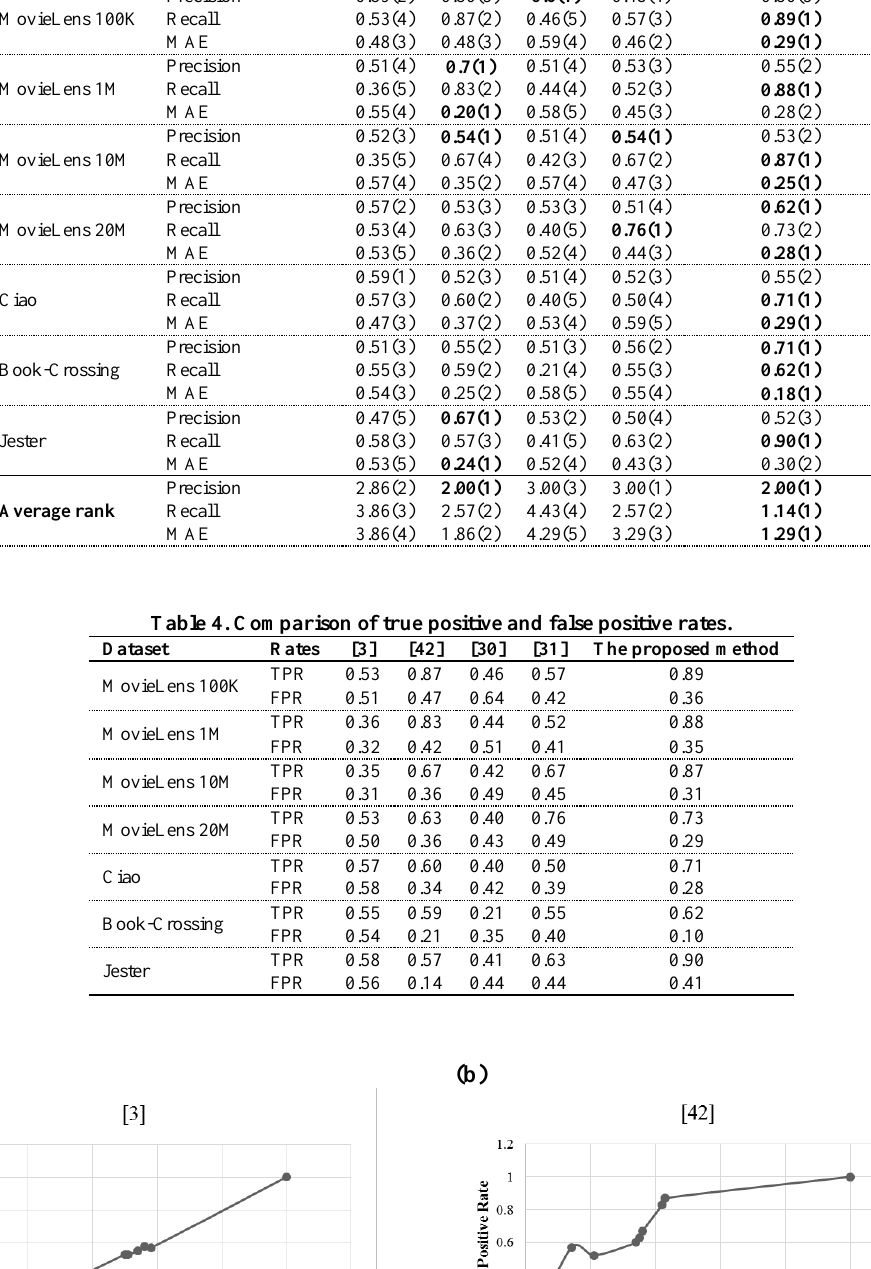
Table 3. The evaluation metrics comparison. Dataset